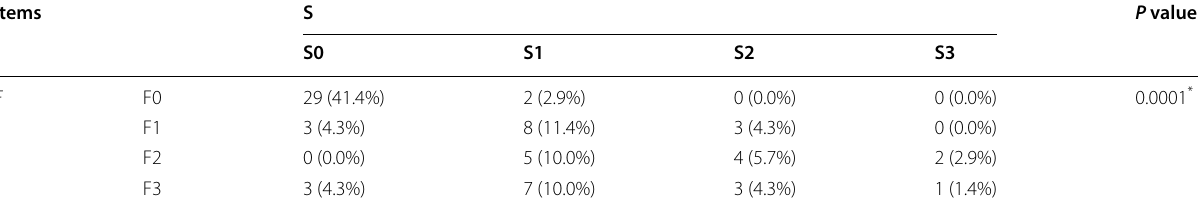
Data are expressed as number (percentage) * Significant ( P value <0.05)